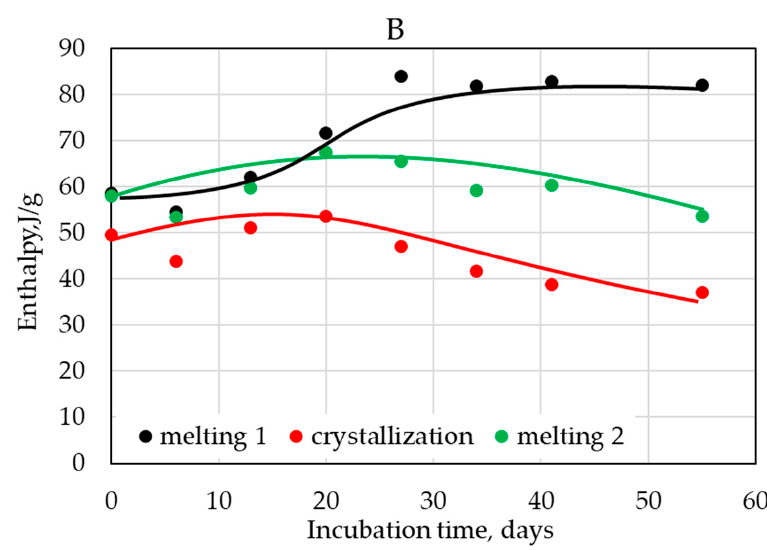
Figure 17. Evolution of enthalpies of melting and crystallization during the incubation in an electric composter for sample B.